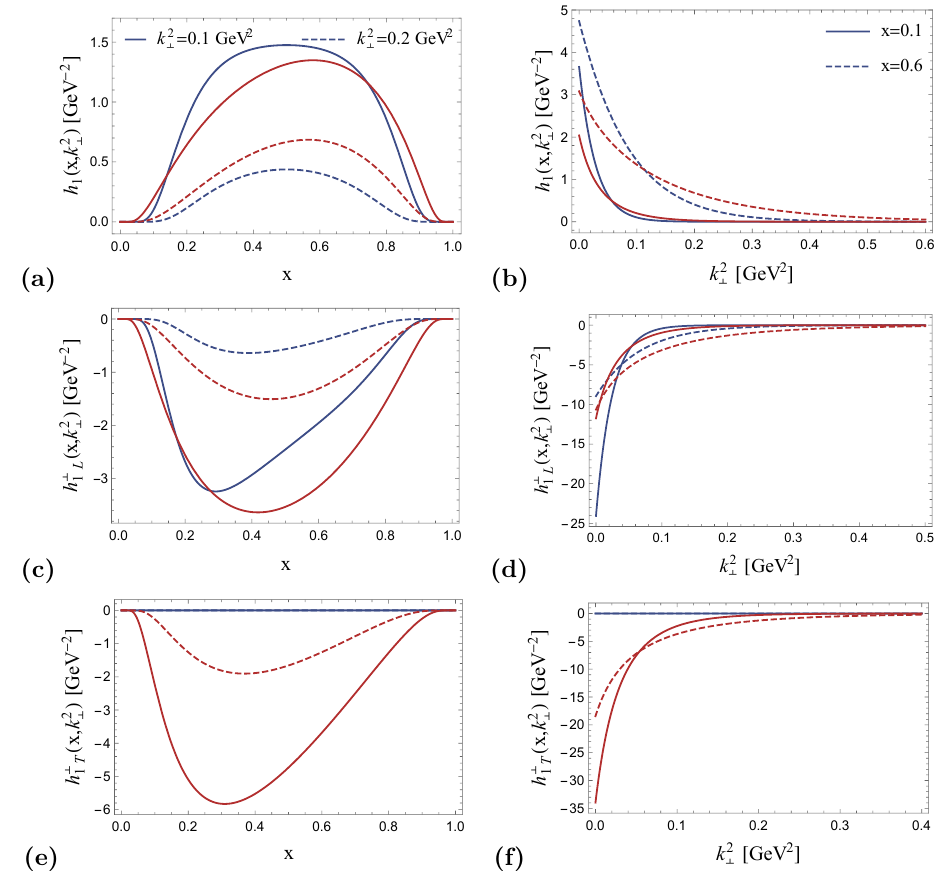
Figure 2 . (Color online) The transversely polarized quark TMDs h 1 ( x, k 2 h ⊥ ( x, k 2 ) with respect to x at different value of k 2 1 T ⊥ and k 2 = 0 . 2 GeV 2 (dashed curves). On the right panel, these TMDs are shown with respect to ⊥ k 2 at different values of x , i.e., x = 0 . 3 (solid curves) and x = 0 . 6 (dashed curves). The blue and ⊥ red curves correspond to the light-front holographic model at the model scale µ 2 and the light-front quark model predictions at the model scale µ 2